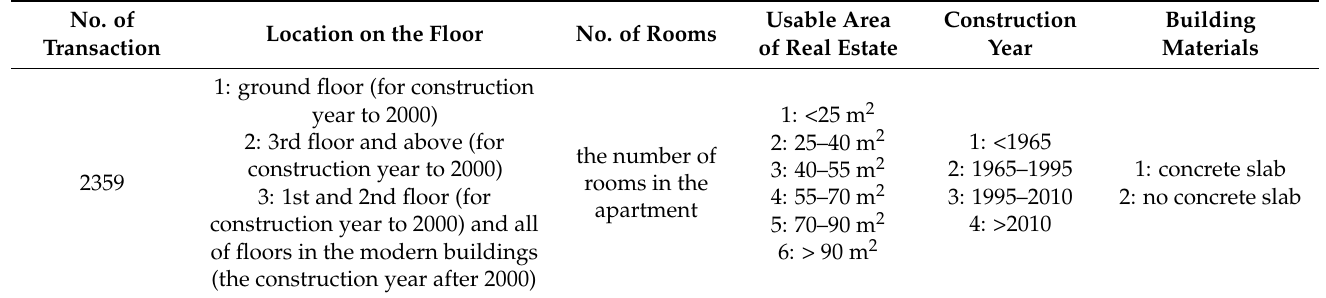
Table 2. Technical attributes in property database. Source: own